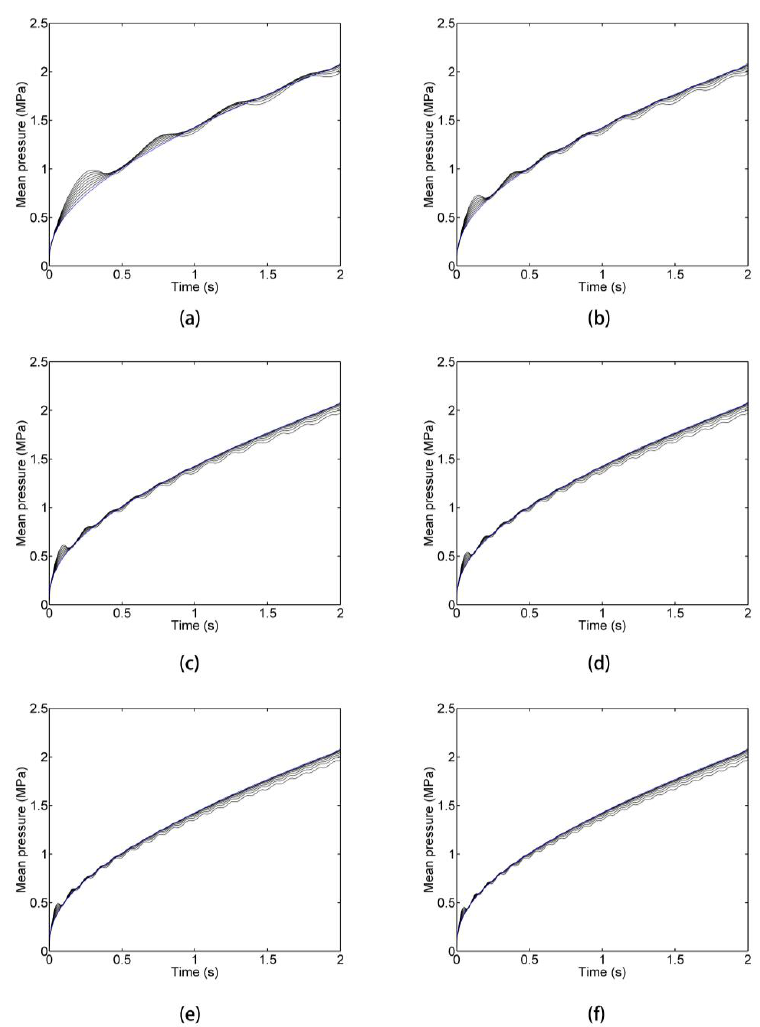
Figure 11. Time domain curves of the mean filling pressure with the same ε as figure 10. ( a ) f = 2 Hz; ( b ) f = 4 Hz; ( c ) f = 6 Hz; ( d ) f = 8 Hz; ( e ) f = 10 Hz; ( f ) f = 12 Hz.